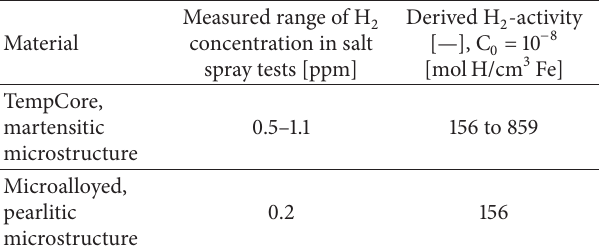
Table 5: Hydrogen activities in salt spray